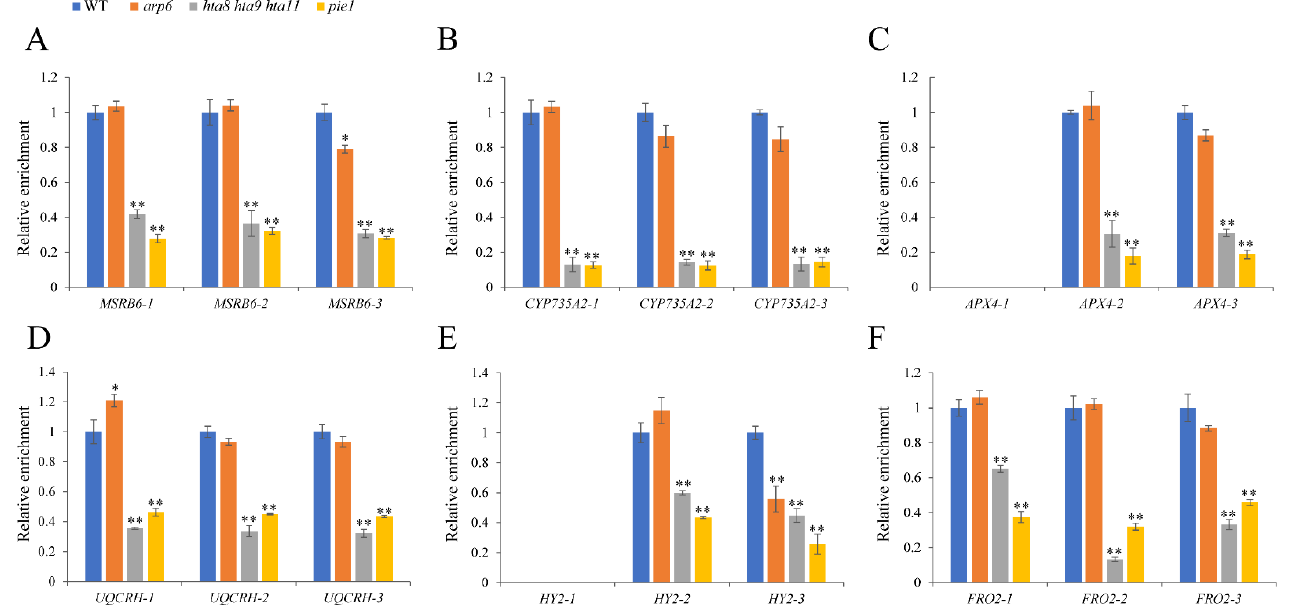
Figure 6. The Pol II level in oxidoreductase activity-related genes was altered in the roots of arp6 , hta8 hta9 hta11 , and pie1 : ( A – F ) ChIP-qPCR analysis of Pol II enrichment in MSRB6 , CYP735A2 , APX4 , UQCRH , HY2 , and FRO2 genes in the roots of WT, arp6 , hta8 hta9 hta11 , and pie1 . Primer set numbers are the same as those listed in Figure 5. Error bars indicate ± SD ( n = 3 replicates). Asterisks above the columns indicate statistically significant differences (* p < 0.05, ** p < 0.01) determined by Student’s t test.